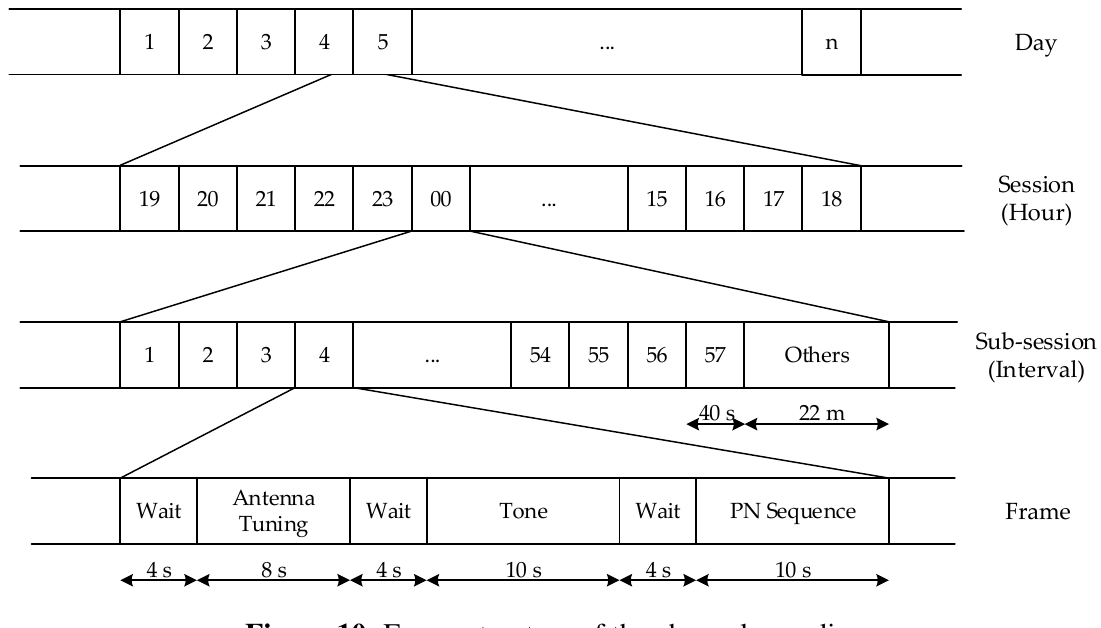
Figure 10. Frame structure of the channel